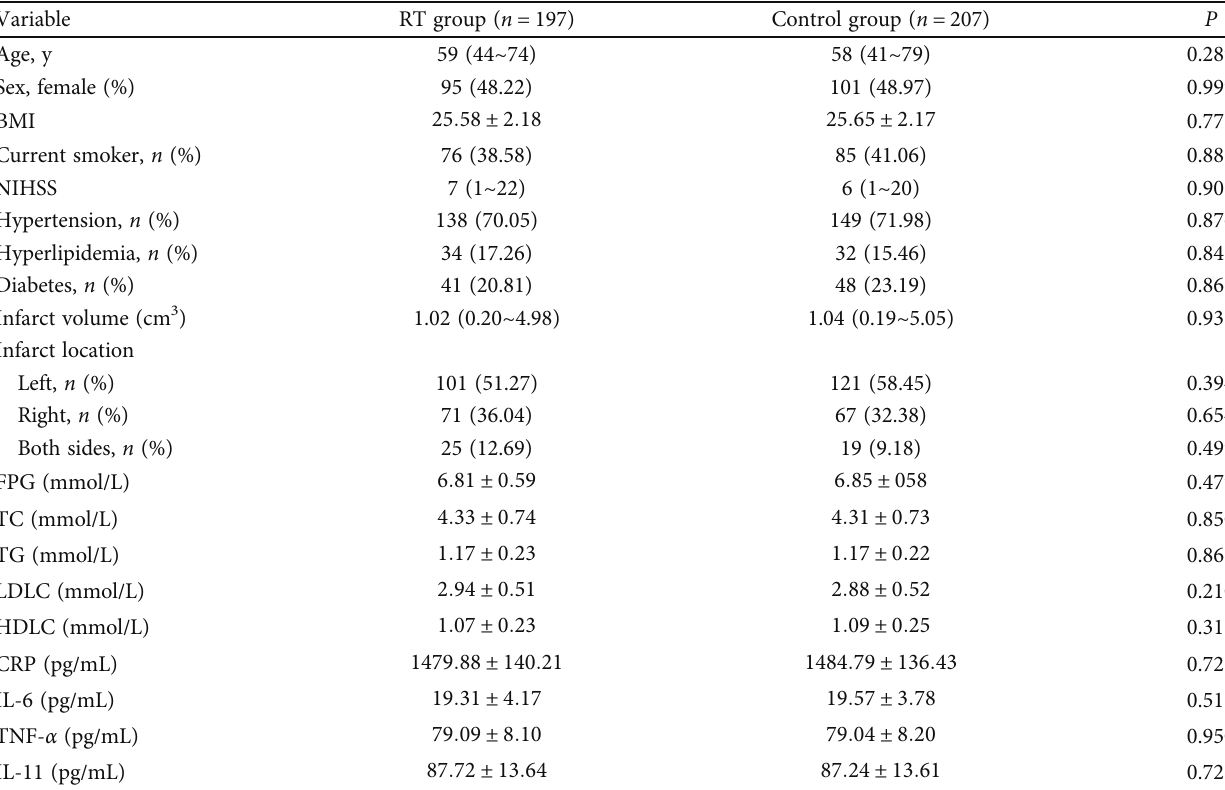
Table 1: Basic characteristics of all